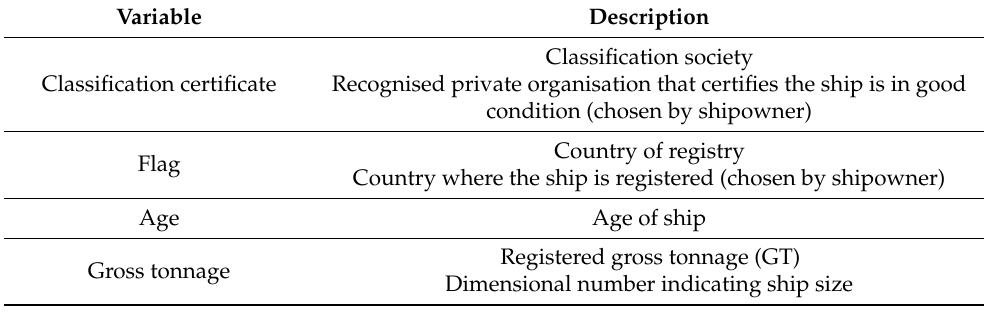
Table 1. Inspected ship variables.